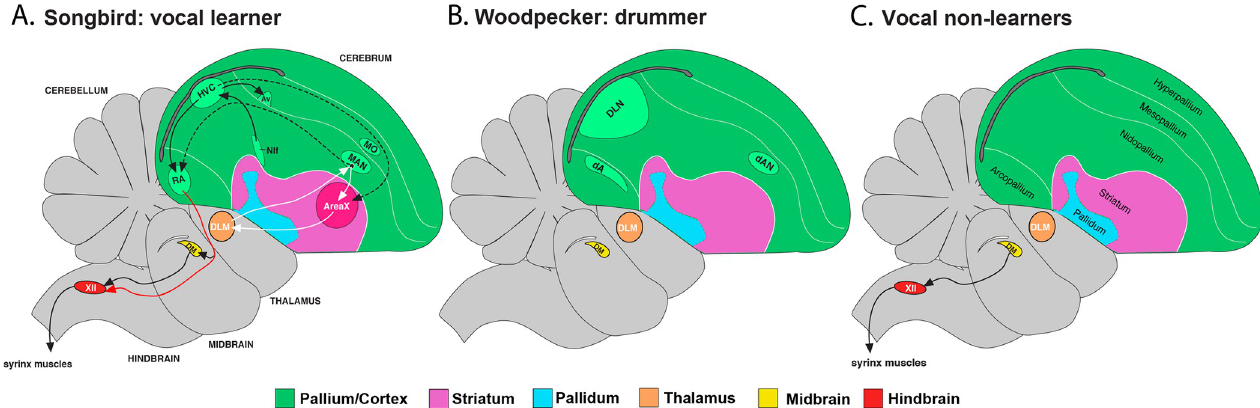
Fig 8. Schematic representation of putative drum control nuclei compared to similar nuclei in avian vocal learners. (A) Diagram showing the song nuclei (RA, HVC, LMAN, and Area X) and their connections (see Fig 1 and text for more details). (B) To date, a conserved molecular marker for drumming nuclei identified 3 telencephalic nuclei (dA, dNA, and DLN) of downy woodpeckers. (C) Nuclei for song learning and woodpecker drumming are absent in vocal nonlearns (chickens, quails,